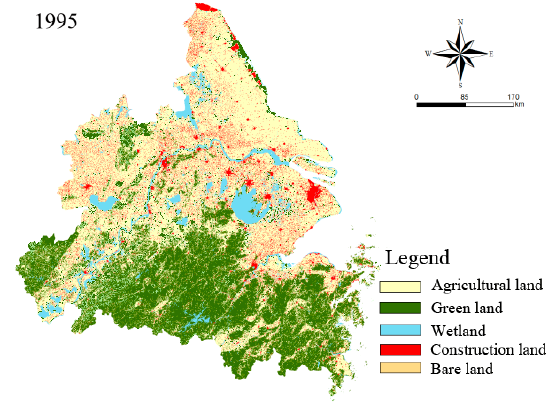
Table 2. Selected indicators of landscape pattern.